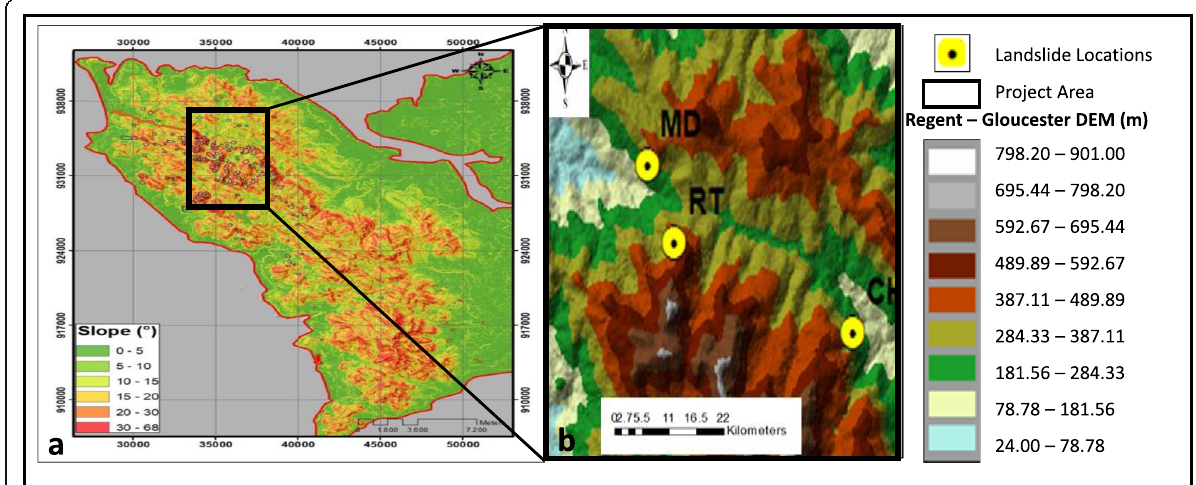
Fig. 10 a Regional Slope and historic landslide map of Freetown showing study area (Source: NMA, 2019); ( b ) DEM of study area projected from Fig. 10a -{Charlotte (CH), Regent (RT) and Madina (MD) landslide